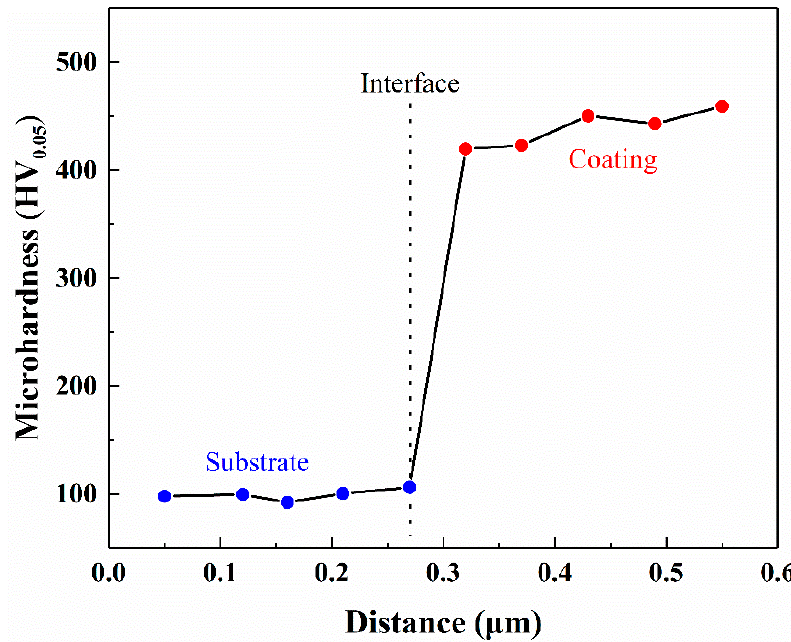
Figure 6. The microhardness of the coating at various depths from the surface.